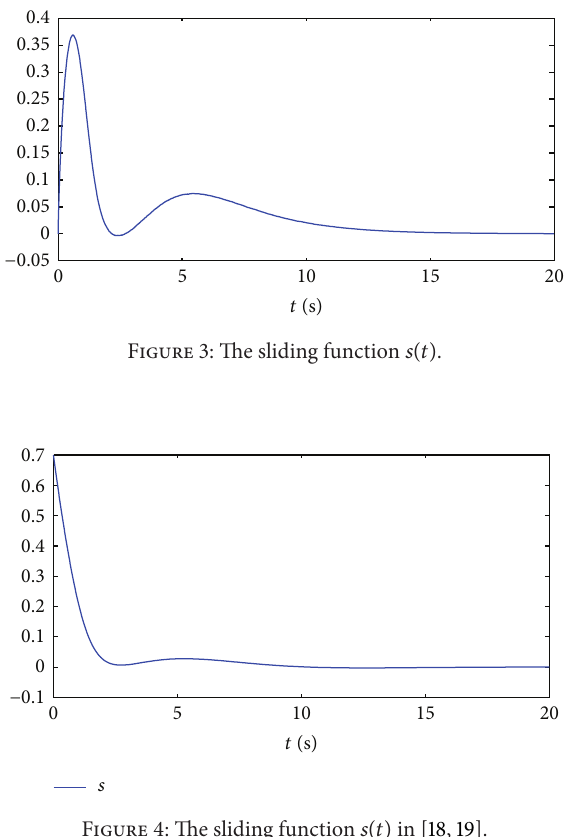
Figure 4: The sliding function 𝑠(𝑡) in [18,